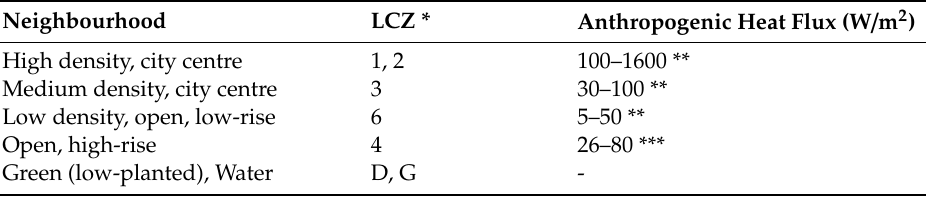
Table A2. Anthropogenic heat flux at the neighbourhood level.